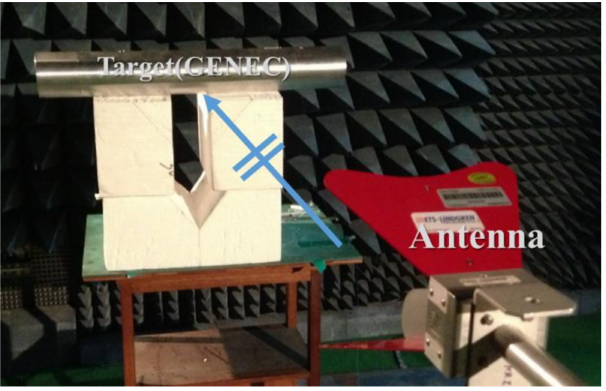
Figure 3. Experiment for the Simplified GENEC model by an external incident wave.